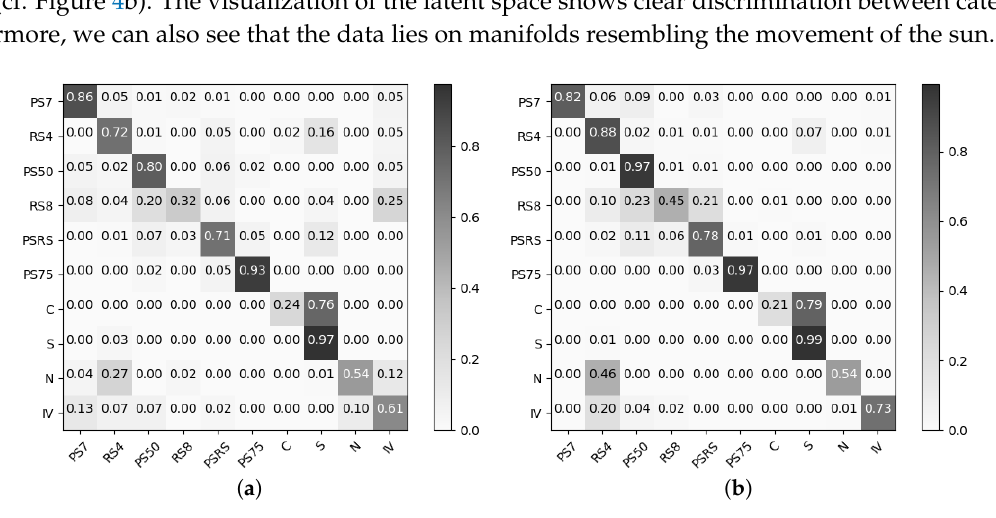
Figure 3. Normalized confusion matrices for ( a ) MLR and ( b ) MLP trained on the fully labeled complex dataset. The x-axis denotes the predicted labels and the y-axis the true labels.